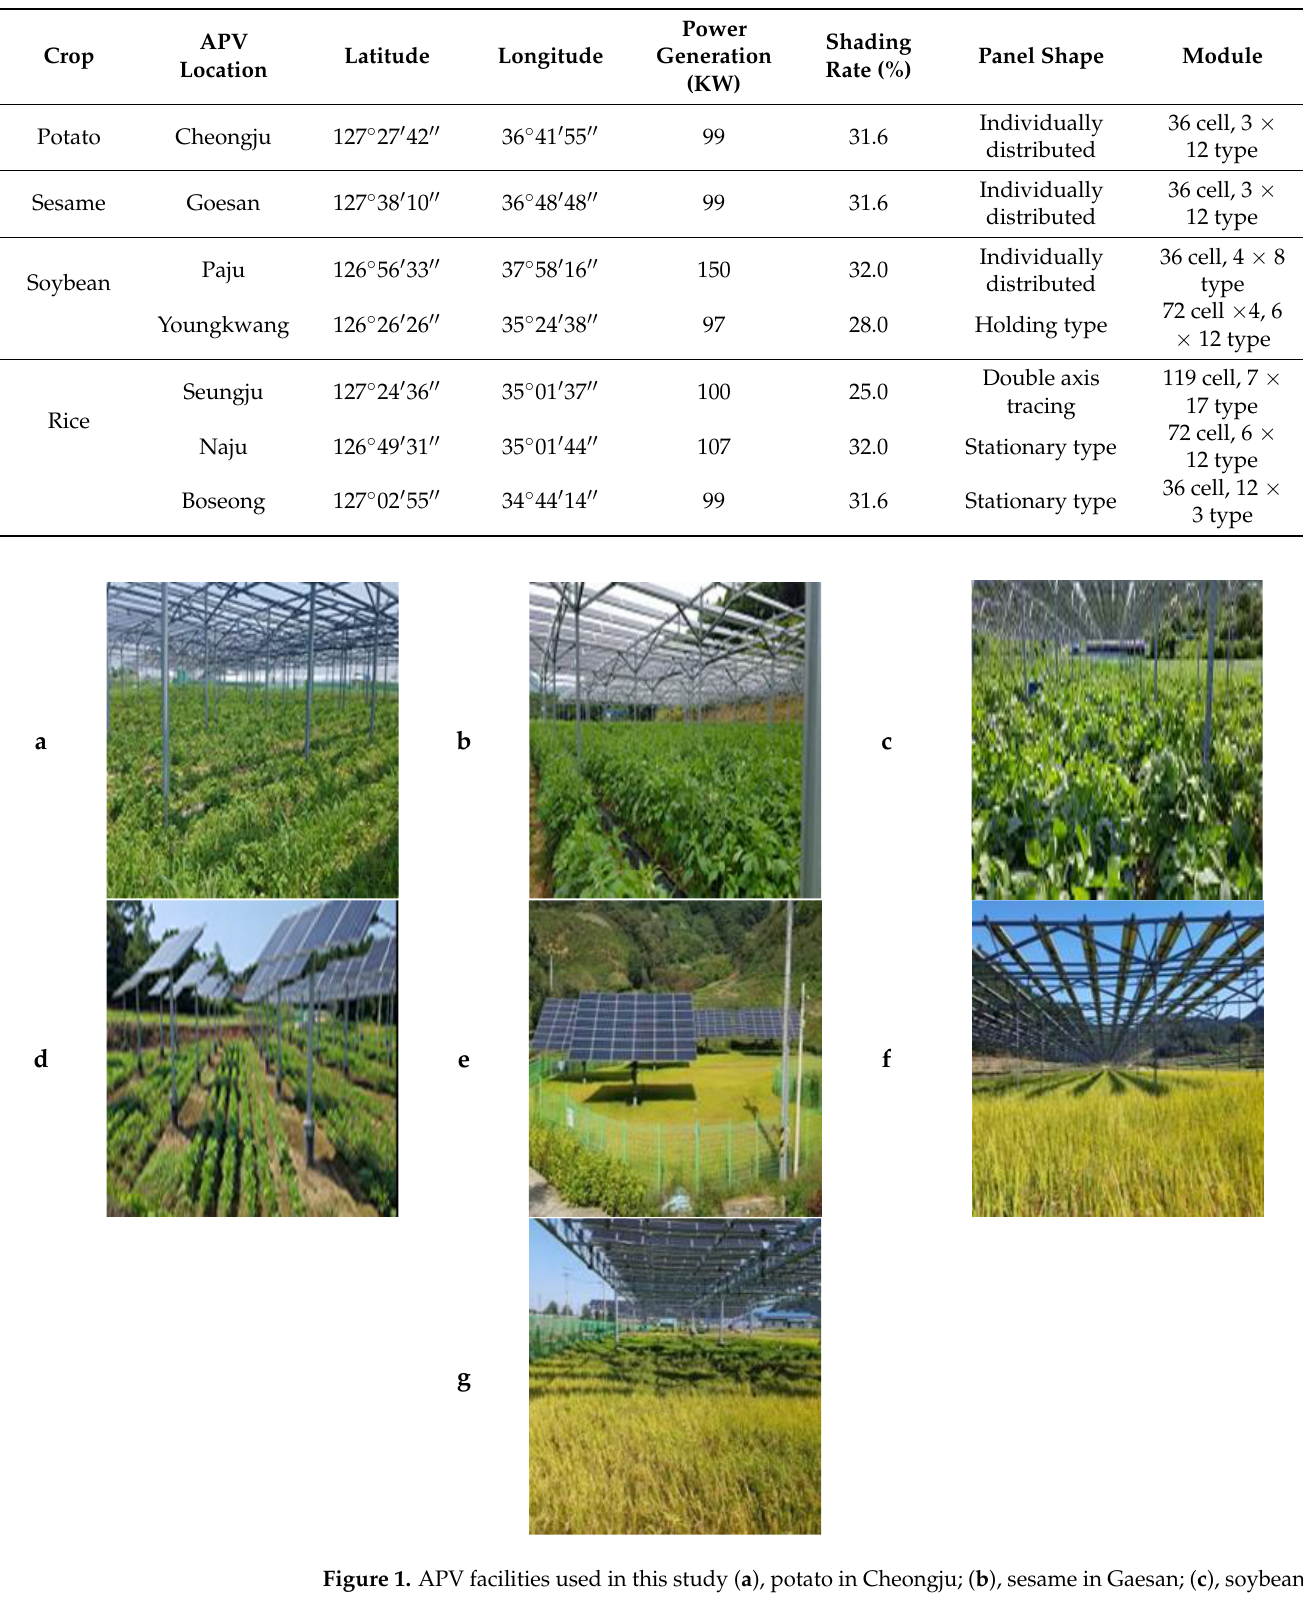
Table 1. Agrophotovoltaic (APV) facilities used in this study.